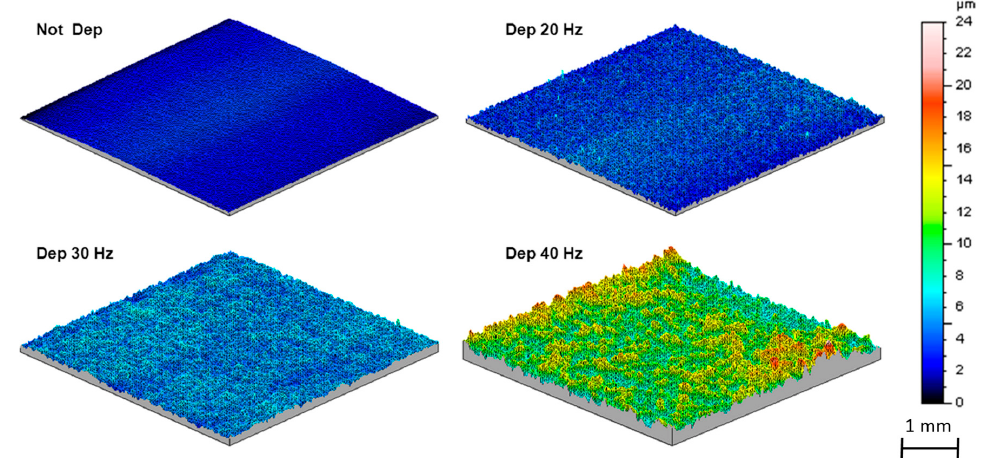
Figure 8. 3D superficial maps of samples.